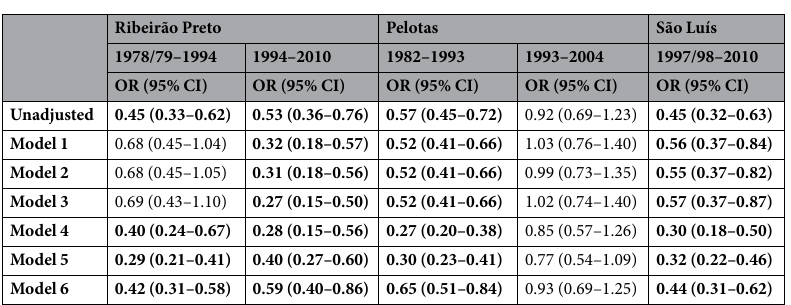
Ribeirão Preto Pelotas São Luís